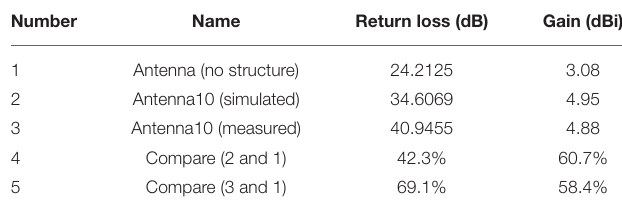
TABLE 4 | The comparison of return loss and